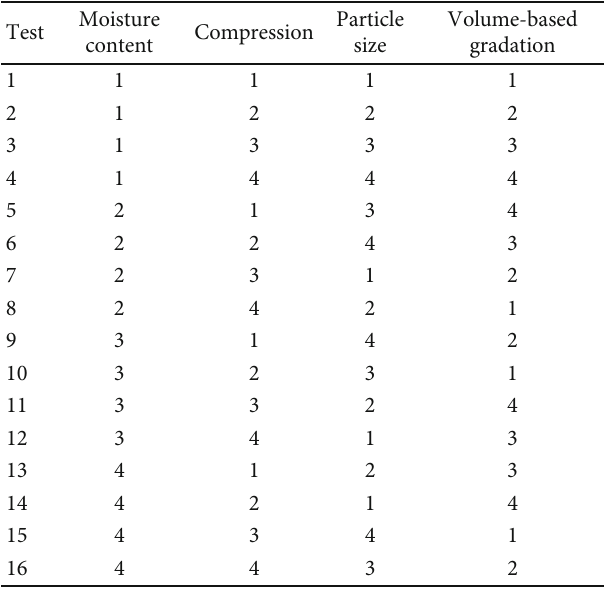
Table 2: Orthogonal design